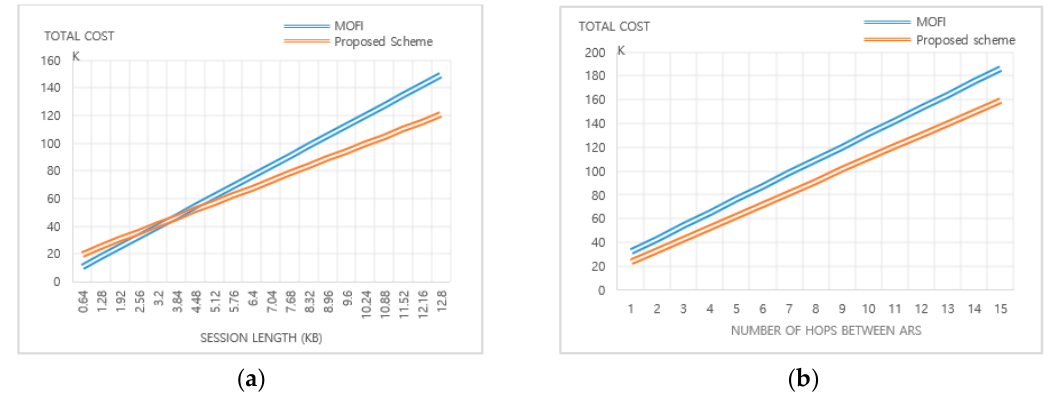
Figure 6. Total cost comparison between MOFI and the. proposed scheme: ( a ) fixed number of hops between ARs (5); ( b ) fixed number of data packets (100).